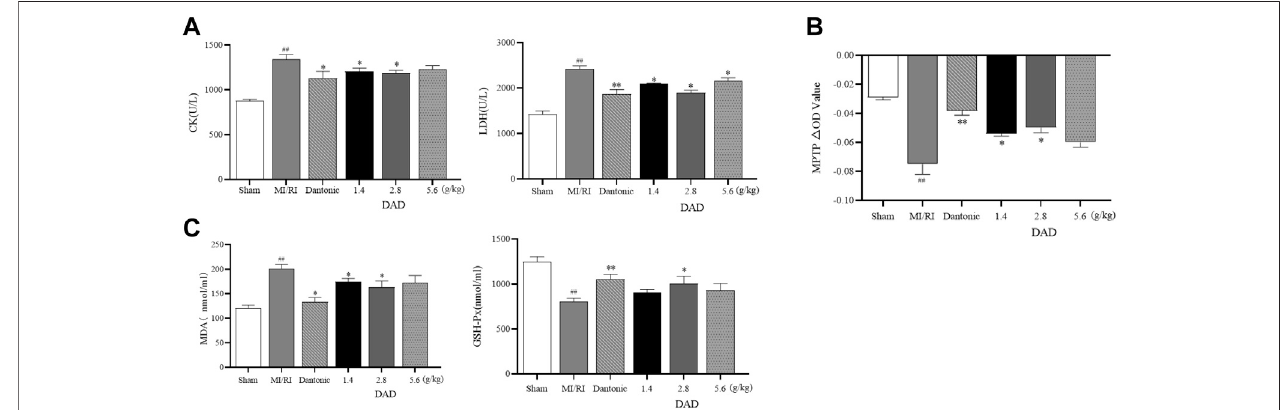
FIGURE8| Effectsofdriedginger-aconitedecoction(DAD)onbiochemicalindicesandMPTPconversionporesinMI/RI rats. (A) Effectsonactivitiesofmyocardial enzymesCK, and LDH. (B) Effectsonmitochondrialtransformationpore MPTP. (C) Effecton oxidative stressfactorsMDA, andGSH-Px. Datawerepresented